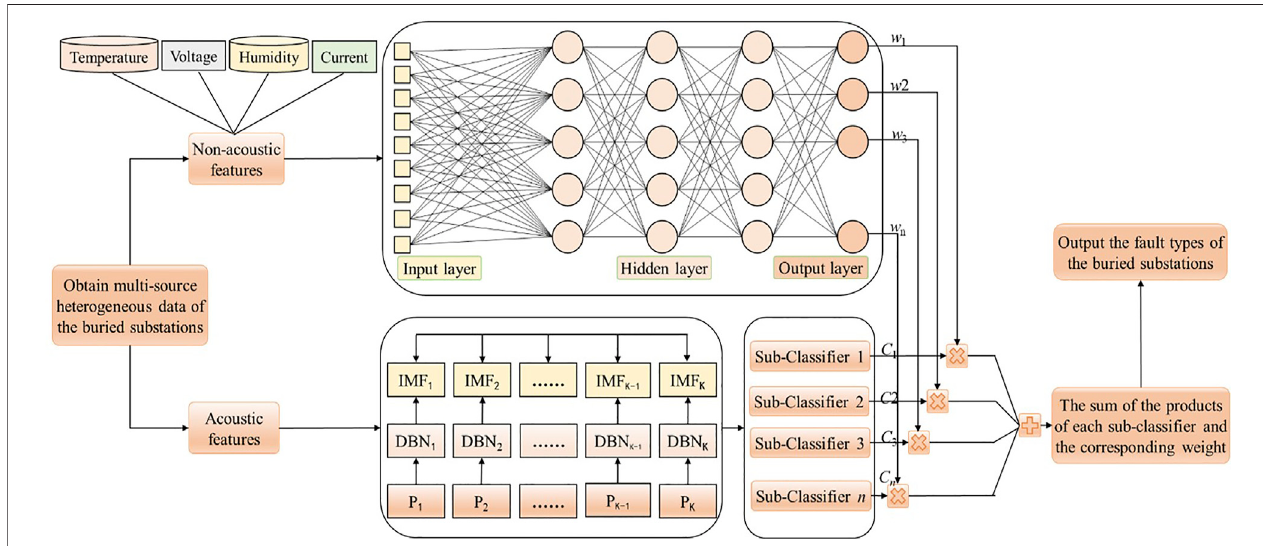
Frontiers in Energy Research |